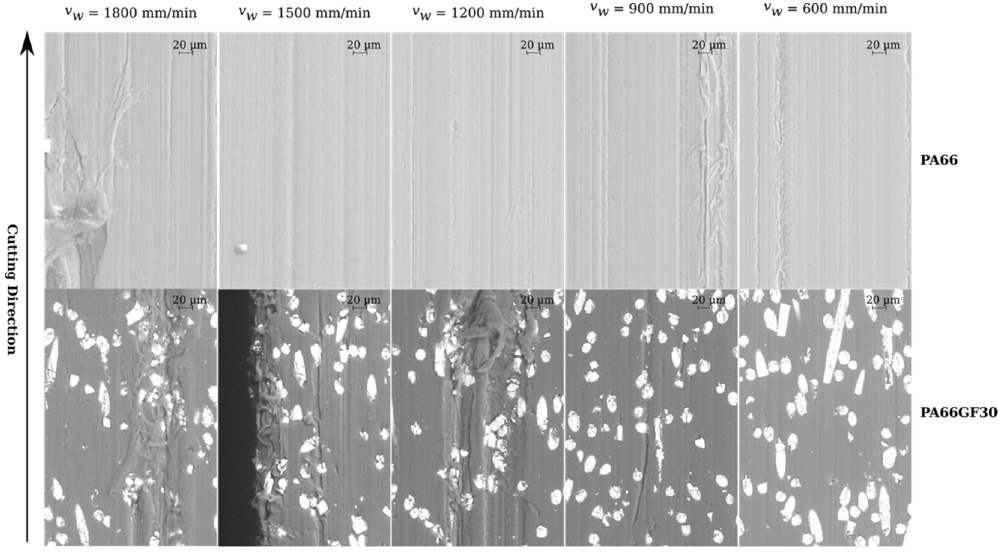
Figure 5. SEM images of the ground surface at 300× amplification.